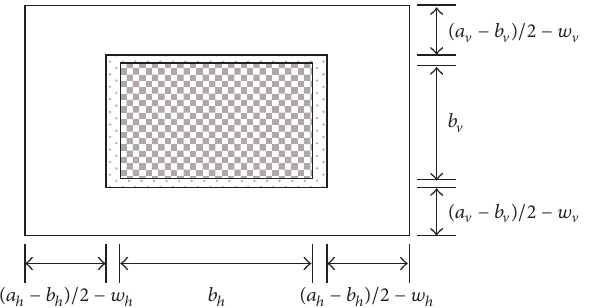
Figure 5: Sketch of the unit cell of the R-W model.